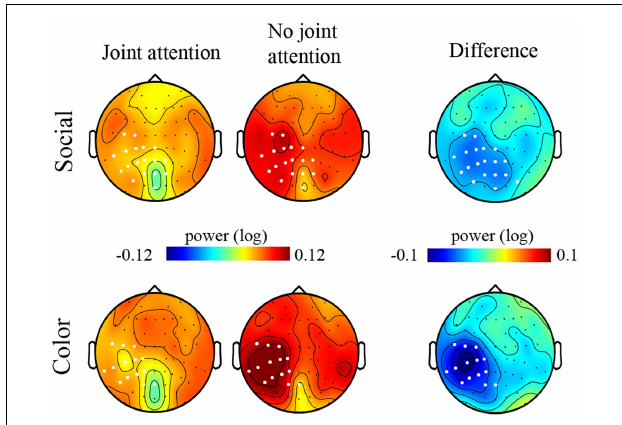
FIGURE 5 | Maps of the signal power in the 11–13Hz frequency band under each experimental condition. Maps (top views of the head) of the grand mean of the signal power between 11 and 13Hz are represented under the Joint attention (left column) and the No-joint attention (middle column) conditions for the Social (upper row) and the Color (lower row) instructions.The difference maps corresponding to the grand mean difference in 11–13Hz signal power for the Joint versus the No-joint attention conditions, under the Social and the Color instruction respectively, are represented in the rightmost column.The white dots on the maps represent the electrodes on which the t -tests revealed a significant difference between Joint and No-joint attention conditions ( p < 0.01) for the socially driven and color-driven instructions